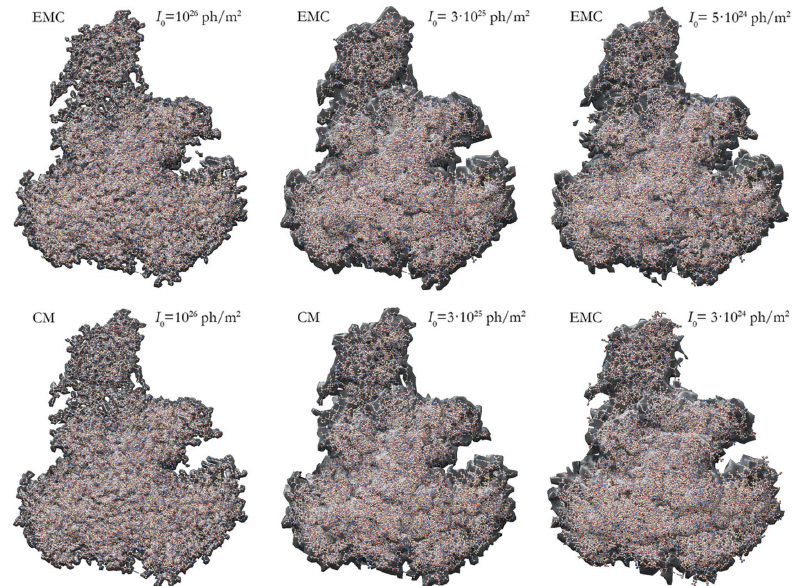
Figure 11 Reconstructed electron density (gray surface) of RNA polymerase II for various XFEL pulse fluences (indicated on the panels). The orientation problem was solved by the CM (bottom left and middle panel) and EMC methods (all other panels). All reconstructed electron densities were rotated and shifted to achieve the best overlap with the original structure (ball-and-stick model) using the Chimera program (Pettersen et al. , 2004).